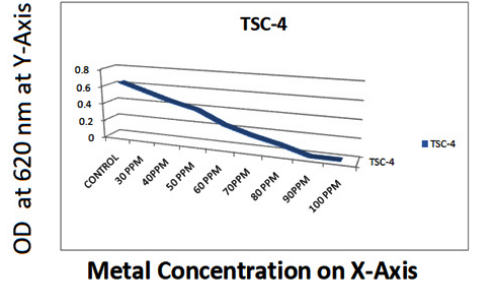
Fig. 5. Effect of Lead on bacterial growth (OD at 620nm)